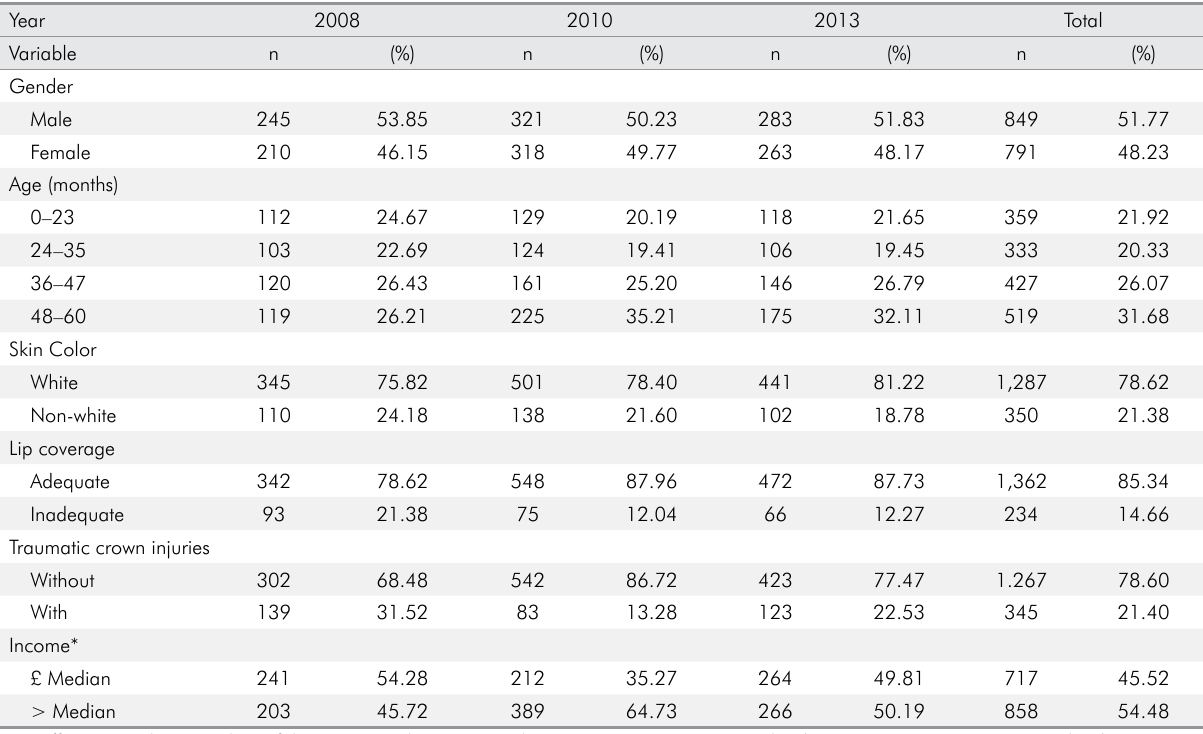
Table 1. Descriptive characteristics of the sample by year. Santa Maria, Brazil.